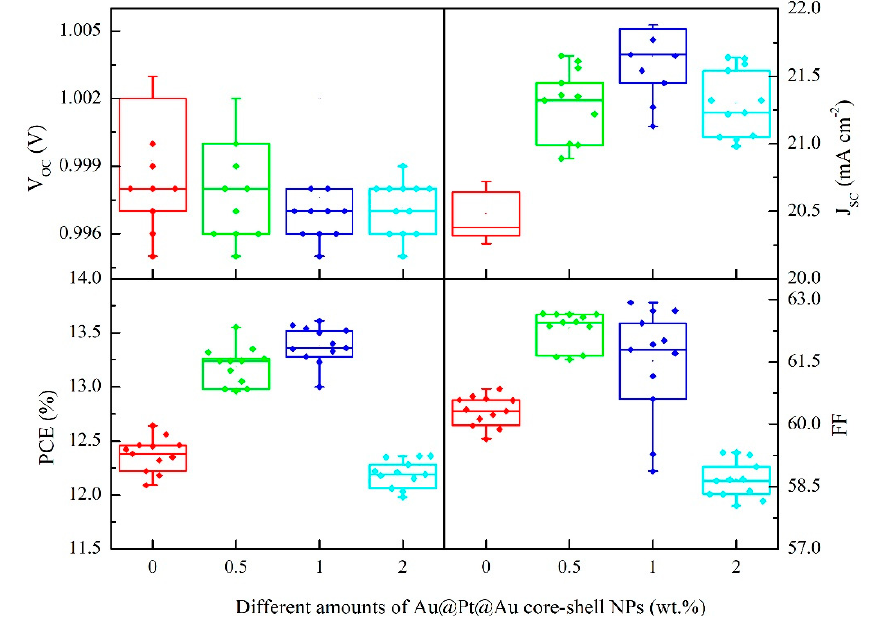
Figure 8. Box charts of photovoltaic arguments for devices incorporated with 0–2 wt.% Au@Pt@Au core-shell NPs under simulated AM 1.5G irradiation (100 mW cm − 2 ). core-shell NPs under simulated AM 1.5G irradiation (100 mW cm